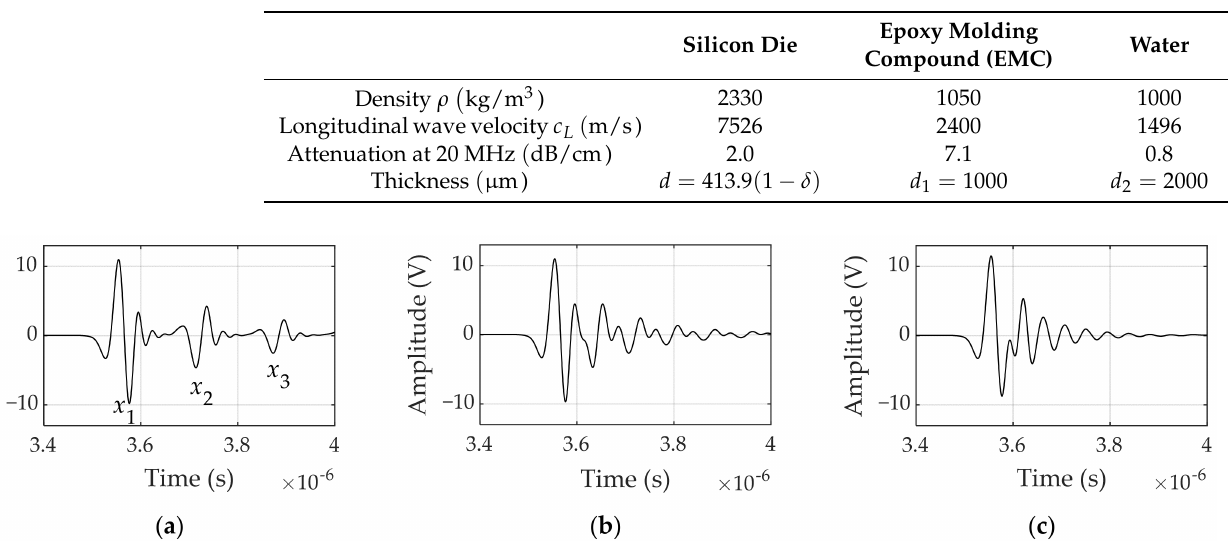
Figure 4. Simple model of scanning acoustic microscopy of electronic packages ( a ) and AMI signal ( b ). Table 1. Material properties.